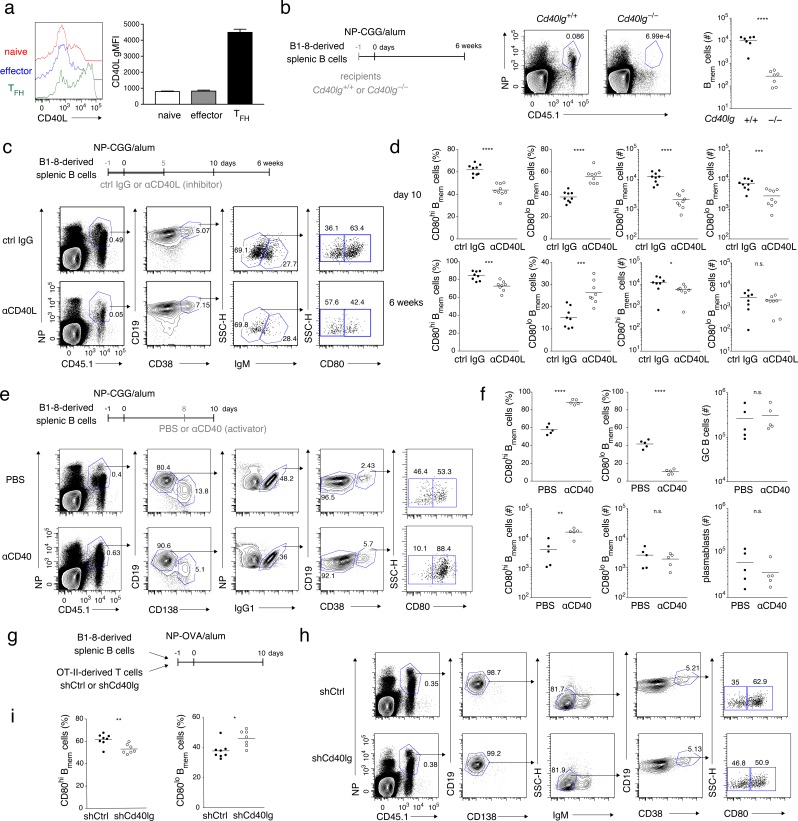
Strong CD40 signaling favors CD80hi Bmem cell development.(a) Naïve T (CD4+ CD62L+ CXCR5− PD-1−), effector T (CD4+ CD62L− CXCR5− PD-1−), and TFH (CD4+ CD62L− CXCR5+ PD-1+) cells were sorted from spleens of mice immunized with NP-CGG in alum 7 days earlier and then stimulated with phorbol myristate acetate (PMA) and ionomycin for 2 hr. CD40L expression on each cell subset was analyzed by FCM (left) and represented as geometric mean fluorescence intensity (gMFI, right) (mean + s.d. of triplicates). (b) Cd40lg+/+ or Cd40lg−/− mice were transferred with splenic B cells from B1-8 ki mice, and immunized with NP-CGG in alum. Six weeks later, the frequency of donor-derived (CD45.1+) NP+ CD19+ B cells (representative data on the left) and the number of the donor-derived Bmem cells (CD19+ CD45.1+ NP+ CD38+; plotted on the right; n = 7) in each spleen were analyzed by FCM. (c, d) B6 mice were transferred with splenic B cells from B1-8 ki mice, immunized with NP-CGG in alum, and injected subcutaneously (s.c.) with an inhibitory CD40L (MR-1: 1 mg/kg) mAb (αCD40L) or an isotype-matched control (ctrl IgG) Ab every day from day −1 to day 5 after immunization. Ten days or 6 weeks after immunization, splenocytes of the recipient mice were analyzed by FCM. (c) Representative data (day 10) of the analysis showing the gating strategy. (d) The frequency (%) of CD80hi and CD80lo cells in the donor-derived, class-switched Bmem cells (CD45.1+ NP+ CD19+ CD38+ IgM−), and their absolute numbers (#) at 10 days (top, n = 9) and 6 weeks (bottom, n = 8) after immunization are plotted. (e, f) B6 mice transferred with B1-8 ki B cells and immunized as in (c, d) were injected intraperitoneally (i.p.) with PBS or a stimulatory CD40 mAb (αCD40) (FGK4.5: 250 μg) at 8 days after immunization. Ten days after immunization, splenocytes from the recipient mice were analyzed by FCM. (e) Representative data of the analysis showing the gating strategy. (f) The frequency (%) and absolute numbers (#) of CD80hi and CD80lo cells in the donor-derived, IgG1+ Bmem cells (CD45.1+ NP+ CD138– CD19+ IgG1+ CD38+), and the numbers of the donor-derived GC B cells (CD45.1+ NP+ CD19+ IgG1+ CD38−) or of plasmablasts (CD45.1+ NP+ CD138+) in splenocytes are plotted (n = 5). (g–i) B6 mice, co-transferred on day −1 with B1-8 ki B cells (1 × 105) and OT-II T cells (1 × 105) that had been transduced with control (shCtrl) or shCd40lg retroviral vectors on the previous day, were immunized with NP-OVA in alum. Ten days after immunization, spleen cells from the recipient mice were analyzed by FCM. (g) Outline of the experimental protocol. (h) Representative data showing the gating strategy. (i) The frequencies of CD80hi and CD80lo cells among the donor-derived, class-switched Bmem cells, defined as in (d) (n = 8). The mean of the values in each group is indicated by a horizontal bar (b, d, f, i). n.s., not significant (p>0.05); *, p<0.05; **, p<0.01; ***, p<0.001; ****, p<0.0001; unpaired Student’s t test (b, d, f, i). All data are representative of two independent experiments except (b) and (i), where data from two independent experiments are combined.10.7554/eLife.44245.007Figure 2—source data 1.Source data for Figure 2b, d, f and i.